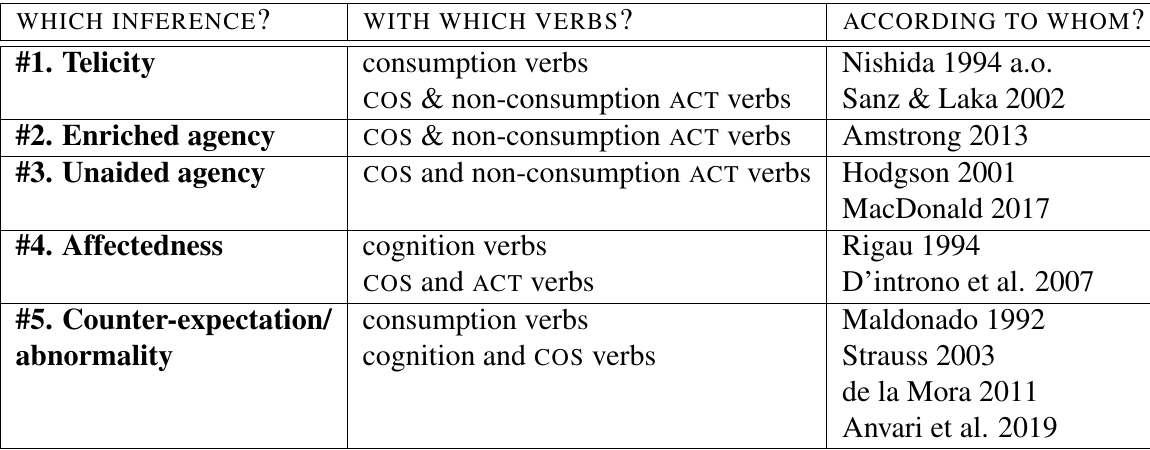
Table 1. Summary of inferences attributed to se in optional se constructions across verb types (‘ COS ’ stands for ‘change-of-state’ and ‘ ACT ’ for ‘activity’) WHICH INFERENCE